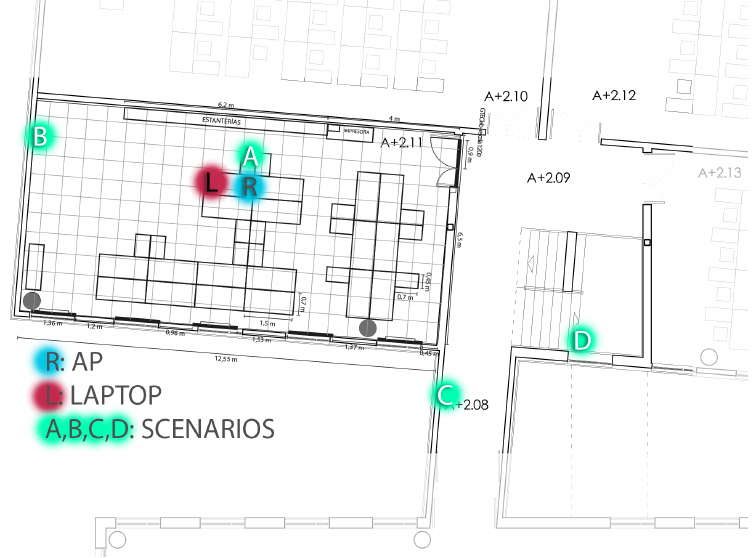
Figure 11. Testing environment. ( A ) Short distance, line-of-sight; ( B ) Medium distance, line-of-sight; ( C ) Medium distance, non-line-of-sight; ( D ) Medium distance, non-line-of-sight, upstairs. ( L : Laptop; R :